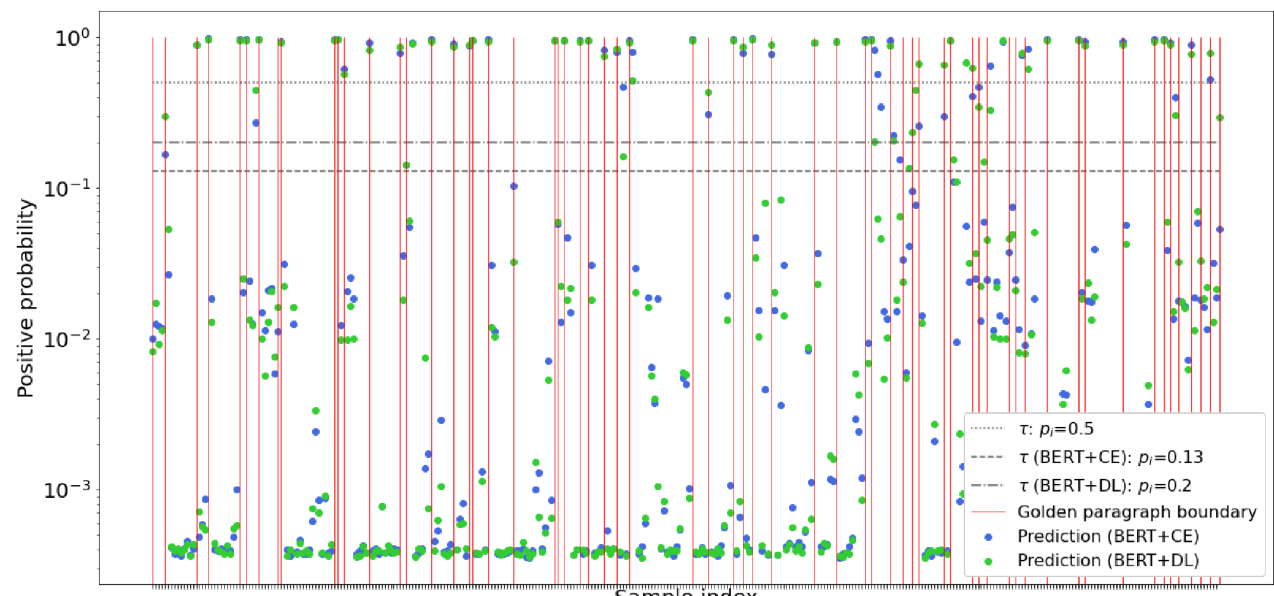
Figure 4. Positive probability in paragraph-boundary recognition for BERT + CE and BERT + DL in the Fitzgerald dataset. Samples are from test data based on the novel “The Great Gatsby”. Vertical axis represents the positive probability for each sample x i : p i = p ( y i = 1 | x i ) . Vertical red lines represent golden paragraph boundaries that were actual positions of paragraph breaks. Each dotted line represents the threshold positive probability. Blue points are BERT + CE predictions, and lime green points are BERT + DL